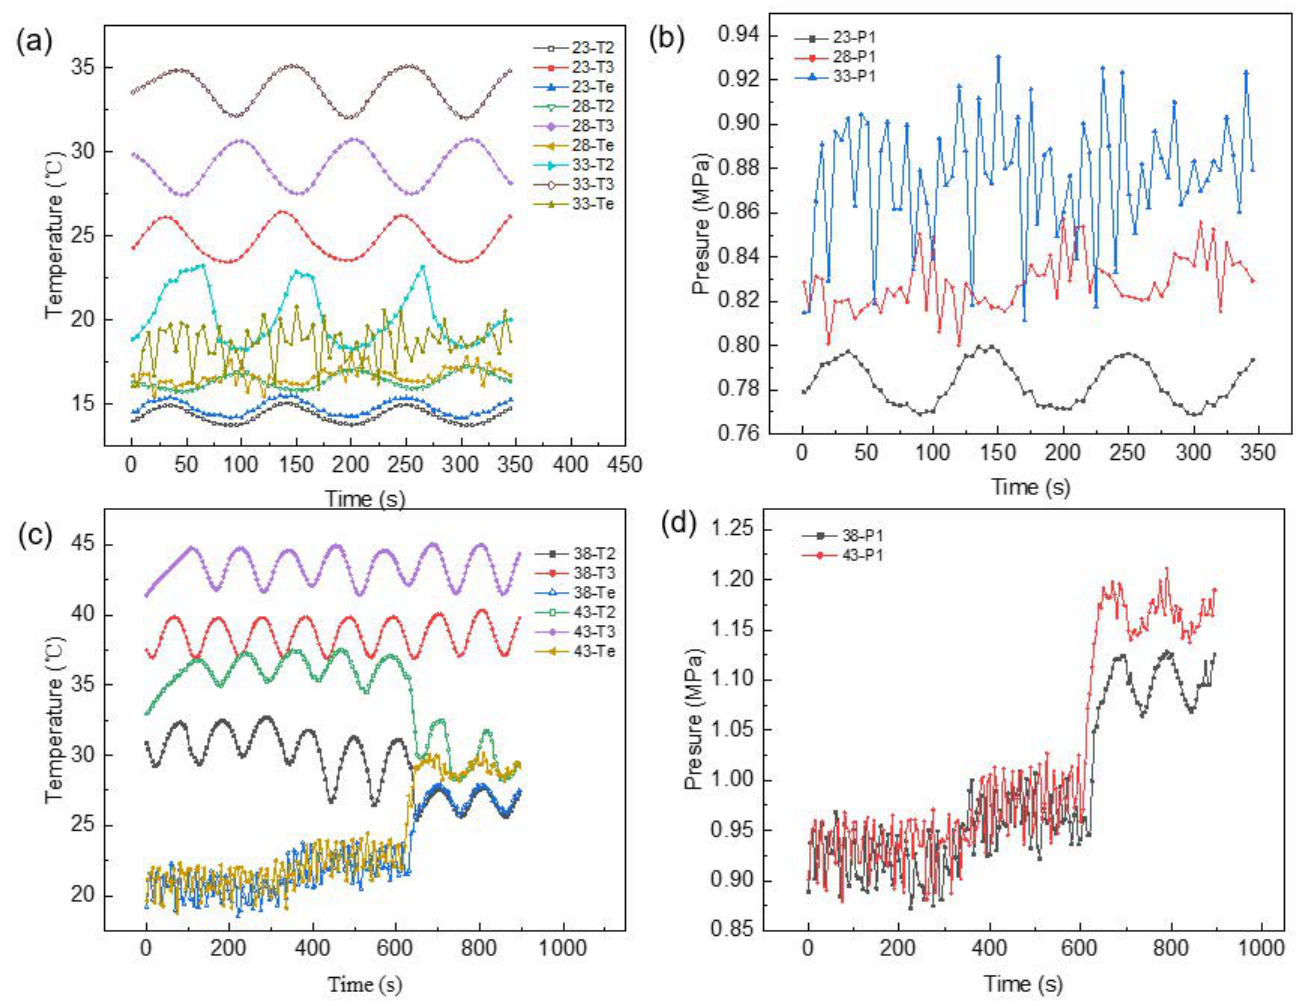
Figure 8. Manual control of the EXV2 curves and response curves ( a ) the curves of T3, T2 and T e when T3 is 23, 28 and 33 ◦ C ( b ) the curves of P1 when T3 is 23, 28 and 33 ◦ C; ( c ) the response curves of T3, T2 and T e when T3 is 38 and 43 ◦ C; ( d ) the response curves of P1 when T3 is 38 and 43 ◦